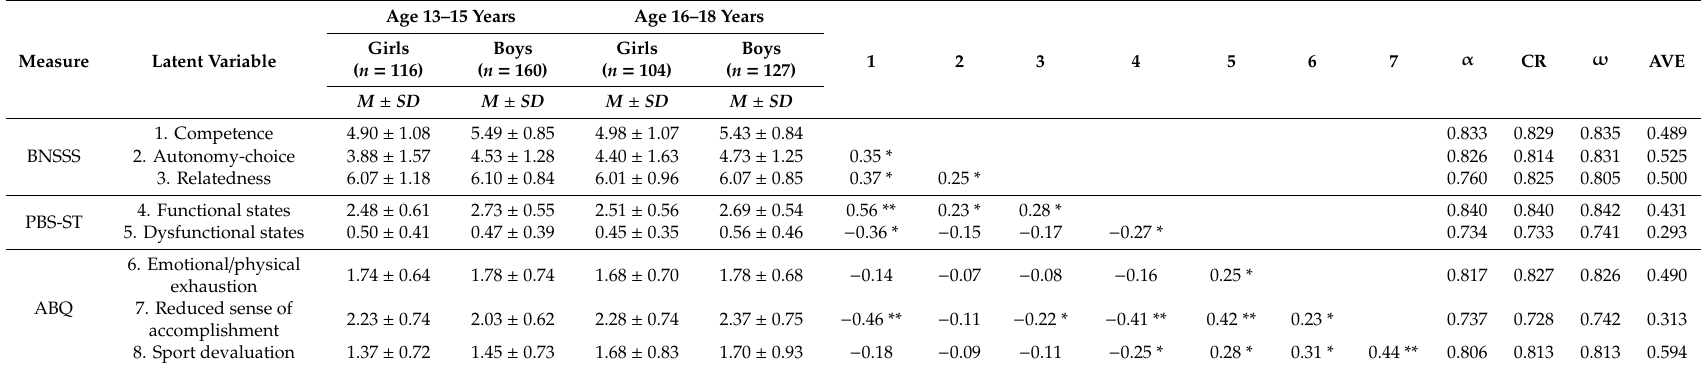
Table 2. Descriptive statistics, Pearson product-moment correlation coe ffi cients, Cronbach’s alpha values ( α ), composite reliability (CR), omega coe ffi cients ( ω ), and average variance extracted (AVE) for the latent variables for the whole sample ( N = 507).